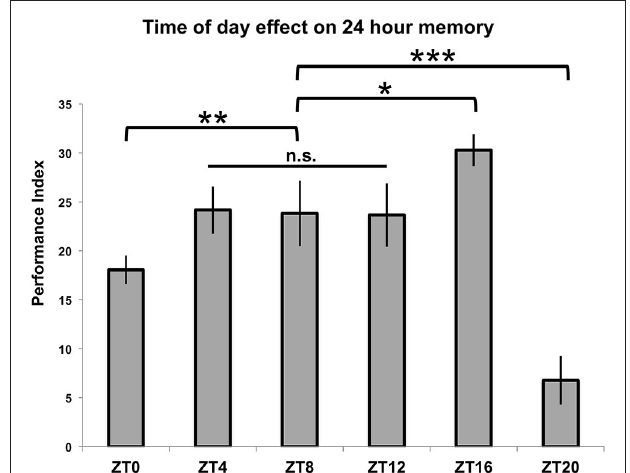
FIGURE 2 | Time of training affects 24-h memory . Wild-type animals were entrained to a 12-12 light-dark schedule, trained with 7x spaced olfactory conditioning at six different Zeitgeber Times (ZTs) throughout the day, tested 24 h after training began ( n = 7–8 for all groups). Performance index values are presented as experimental means and error bars indicate SEM. Animals trained at ZT4, ZT8, and ZT12 exhibited statistically similar memory scores ( p > 0.9 for all individual comparisons between groups) and were therefore combined to serve as a baseline memory value for other comparisons. Animals showed diminished memory scores compared to baseline when trained at ZT0 ( p < 0.01) and ZT20 ( p < 0.001), while animals trained at ZT16 displayed enhanced memory retention ( p < 0.05). Statistical differences between groups are indicated as * p < 0.05, ** p < 0.01, and *** p <